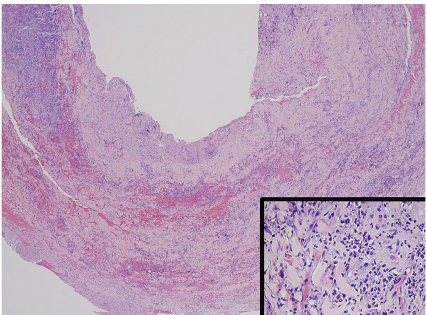
Figure 2: Low-power photomicrograph of resected aortic segment with hematoxylin and eosin stain shows inflammation of aortic wall. Inset: high-power photomicrograph of resected aortic seg- ment with hematoxylin and eosin stain shows abundant neu- trophylic infiltration of aortic wall without detection of the